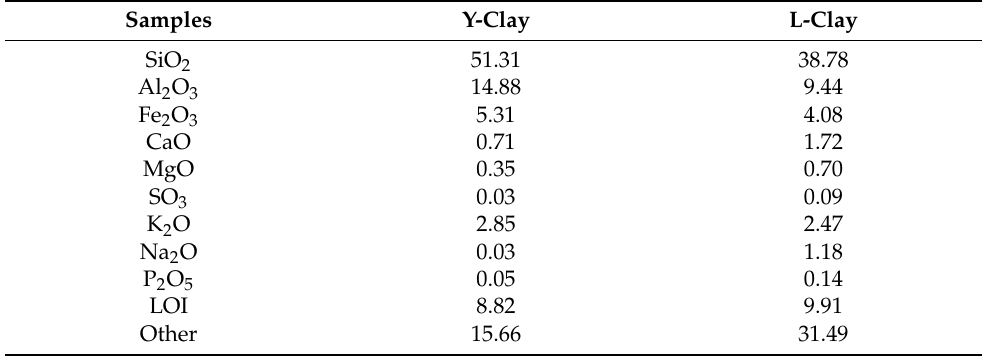
Table 2. Chemical Analysis of Y-Clay and